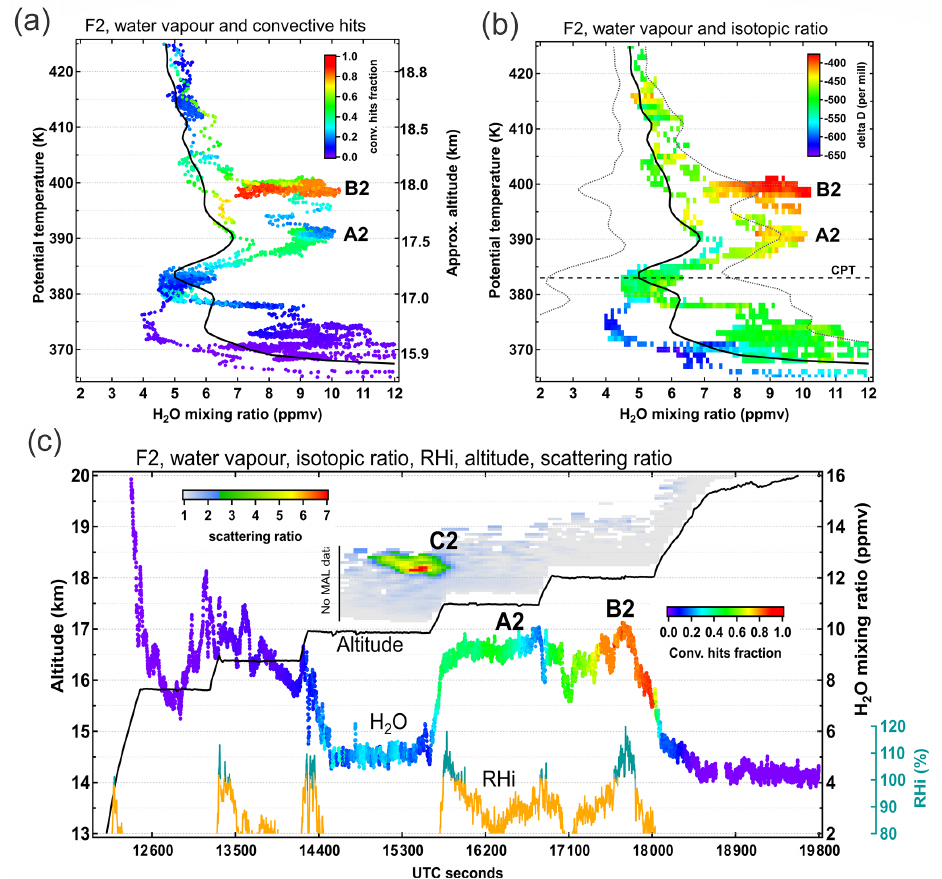
Figure 6. Results of F2 measurements (29 July) with the features of interest marked A2, B2 and C2. (a) Water vapour profile (FLASH) colour-coded by convective hits density (see text for details). (b) Same as panel (a) but colour-coded by the ChiWIS HDO / H 2 O isotopic ratio. The black solid and dashed curves depict the campaign-median H 2 O profile and 2 standard deviations respectively. (c) Time series of flight altitude (black curve), water vapour (colour-coded by convective hits density) and RHi (right-hand axis) computed from FLASH and TDC measurements. The colour map shows the scattering ratio measured by MAL